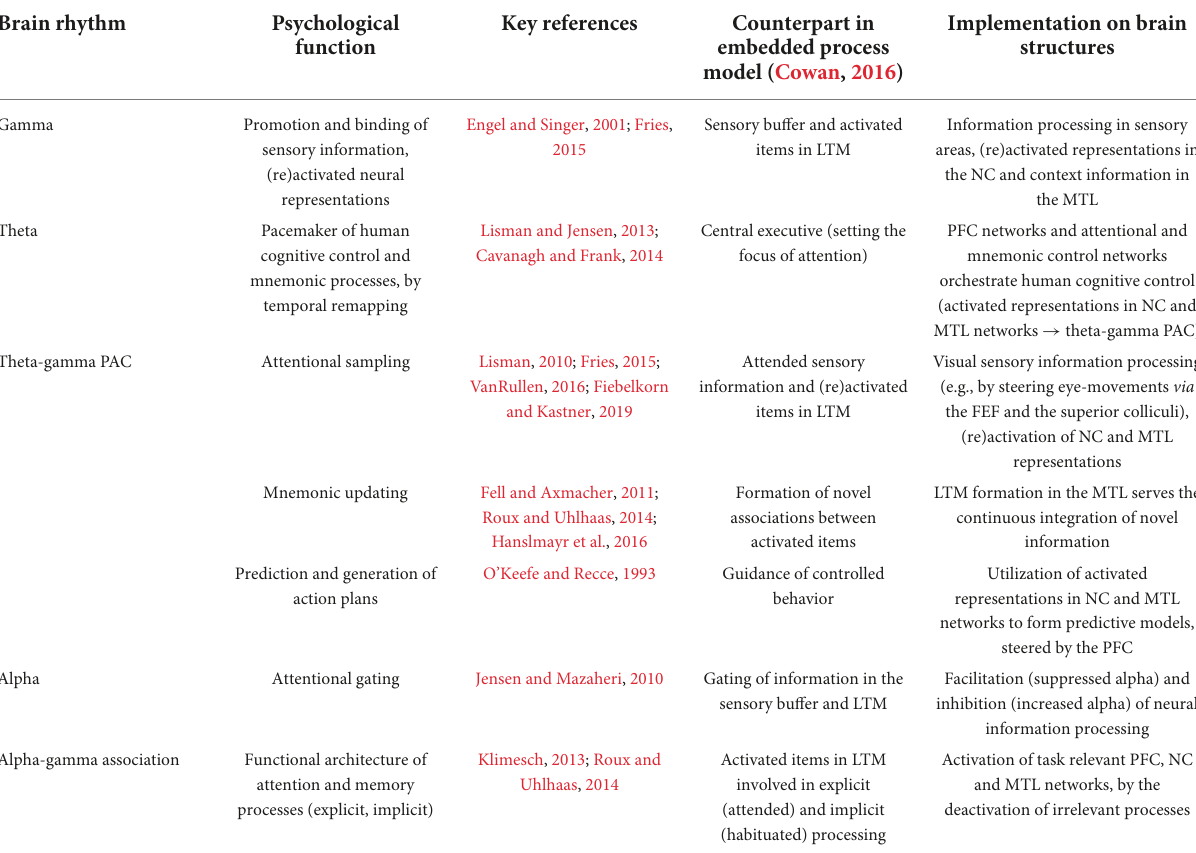
TABLE 1 Overview of the proposed